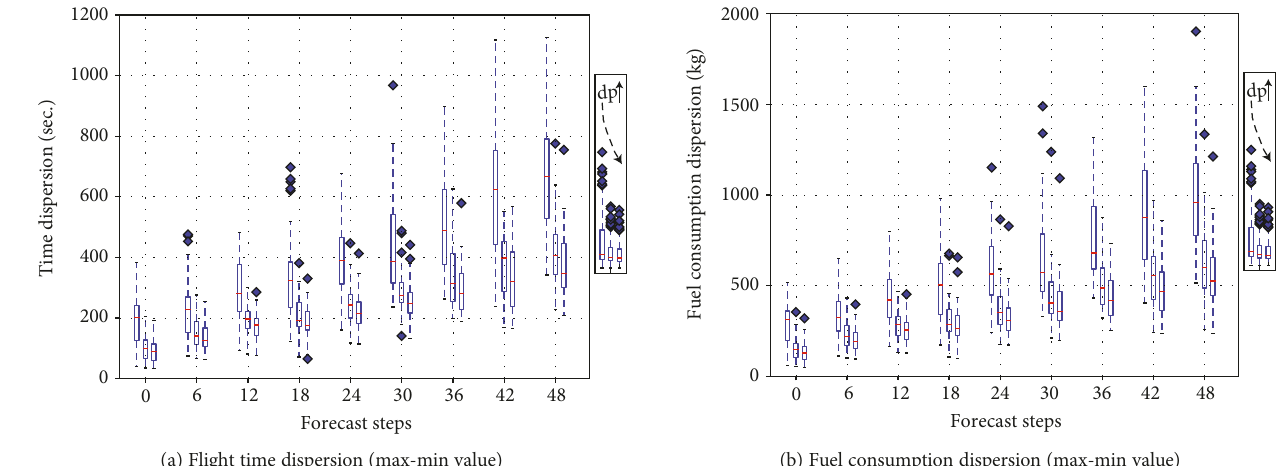
Figure 13: Aggregated dispersion boxplots multiple origin-destination (long haul).